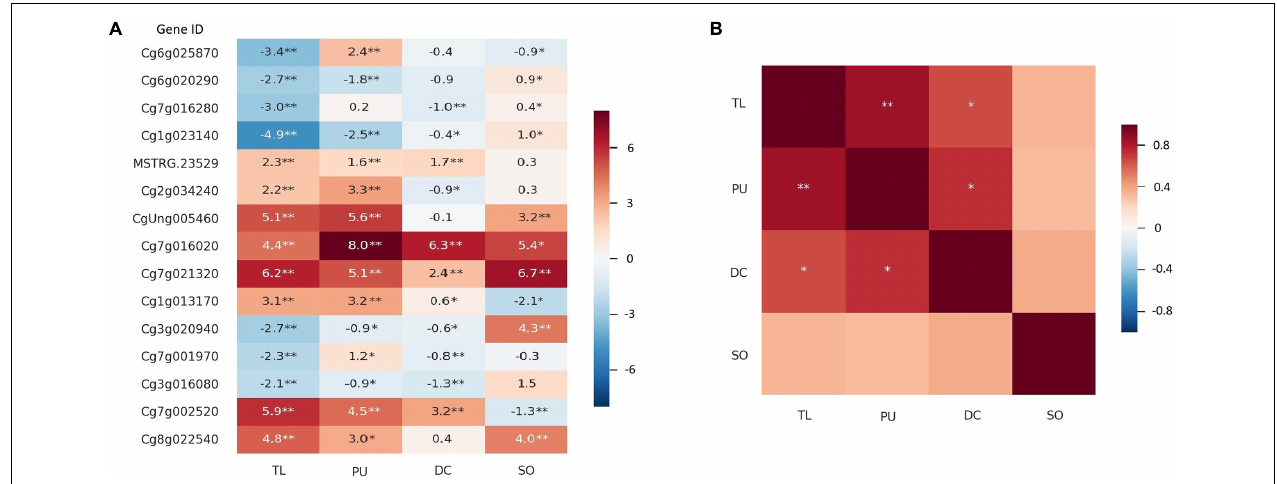
FIGURE 4 | Expression of DEGs in more Citrus thornless bud-sports. The RNA-seq and qPCR results for the thornless pummelo bud-sport were shown as TL and PU, respectively. The qPCR results for Duncan grapefruit (DC) and sour orange (SO) were shown in the graphs. Single and double asterisk(s) indicate statistical significance at p < 0 . 05 and p < 0 . 001 levels, respectively. (A) Expression of 15 genes in bud-sports compared with their corresponding original types. The values in the cells were log2(expression value in bud-sport/expression value in original type) for RNA-seq and – (cid:49)(cid:49) Ct for qPCR. (B) Correlation of gene expression on the 15 genes among the citrus